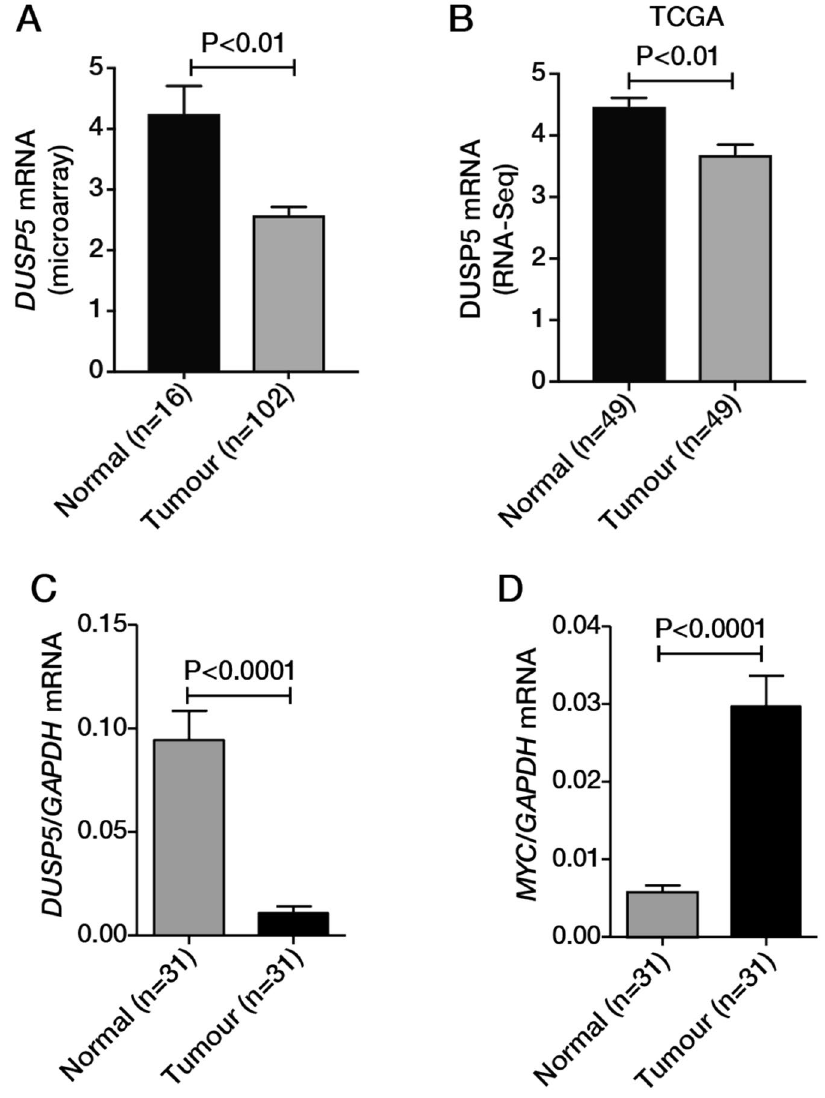
Figure 1. Downregulation of DUSP5 mRNA expression in CRC. DUSP5 mRNA expression in normal colonic mucosa and colorectal tumours determined by analysis of ( A ) an in-house Affymetrix microarray dataset and ( B ) RNA-Seq data available from the TCGA. ( C ) DUSP5 and ( D ) MYC mRNA expression in colon tumour/ normal pairs normalised to GAPDH